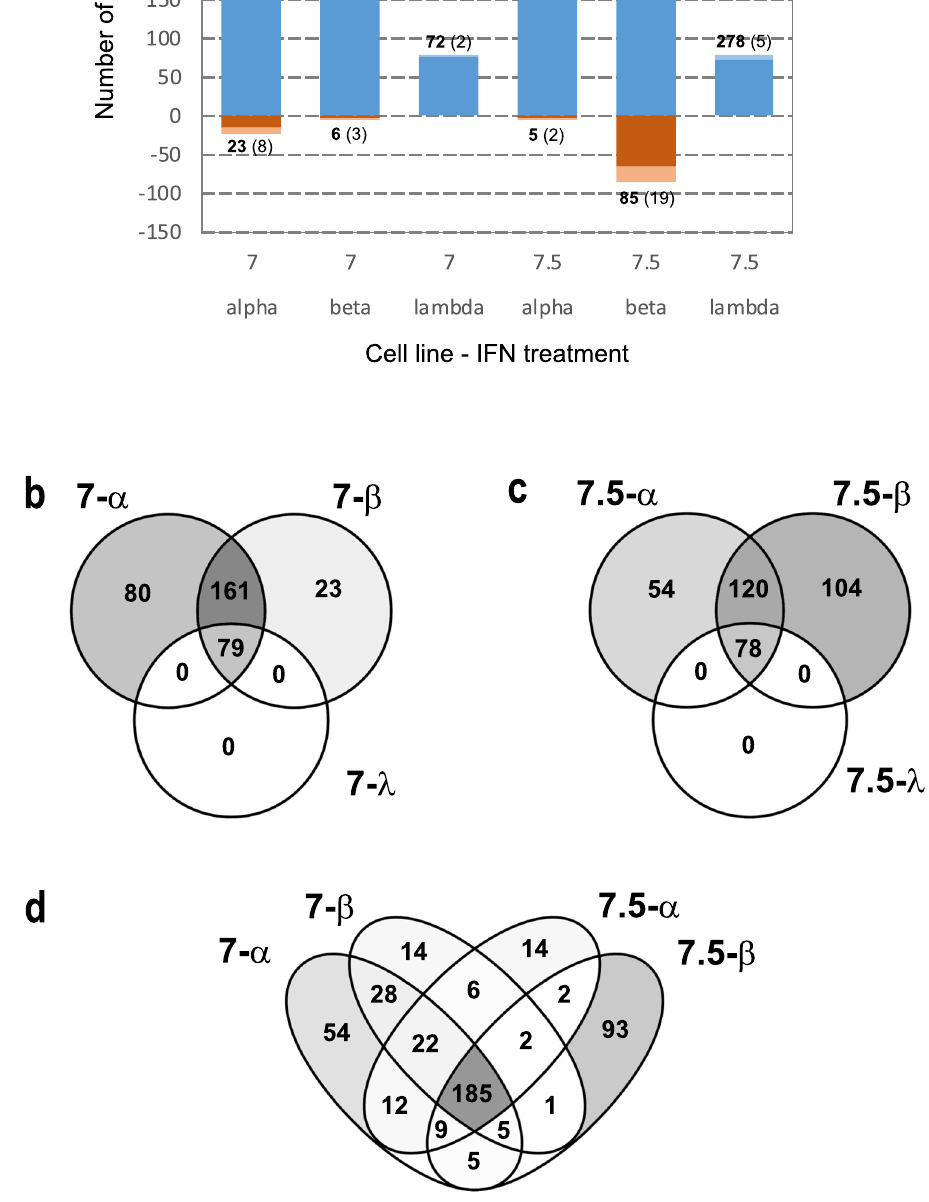
Figure 1. Differential expression analysis on RNASeq transcriptome profiling. ( a ) Number of differentially expressed genes that are significantly modulated in each treatment compared to mock-treated cells after DESeq2 analysis with FDR < 0.05 and absolute Log2FC > 1. Over expressed (blue) and downregulated genes (rust red): dark colours for protein coding genes (actual numbers in bold) and light colours for non-coding genes (actual numbers in brackets). ( b – d ) Venn diagrams illustrating the overlap of modulated genes across treatments. Panel ( b ) shows the overlap between IFNα and IFNβ treatments in the Huh7 line, while panel ( c ) shows the same results for Huh7.5. In both lines, the genes modulated by IFNλ are entirely included in the overlapping region of other two Interferons. Panel ( d ) shows how all genes in ( b ) and ( c ) overlap, showing a group of 185 genes modulated in all cell lines and by both type I IFN